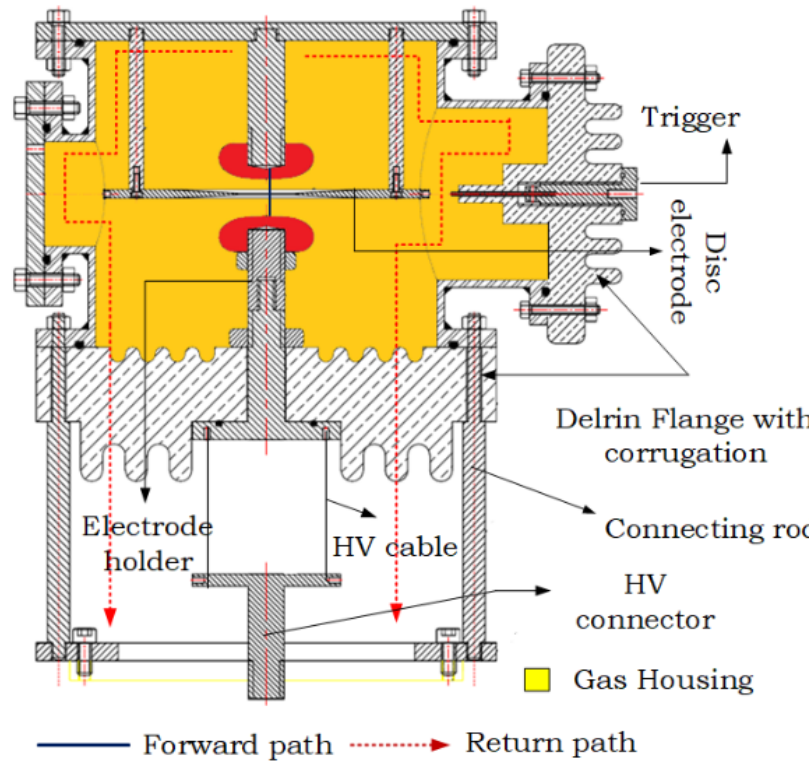
Figure 11. Constructional schematic of coaxial sparkgap switch.